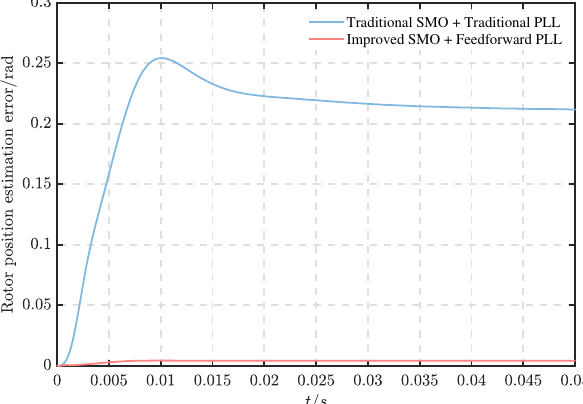
Figure 12. Rotor position observation errors